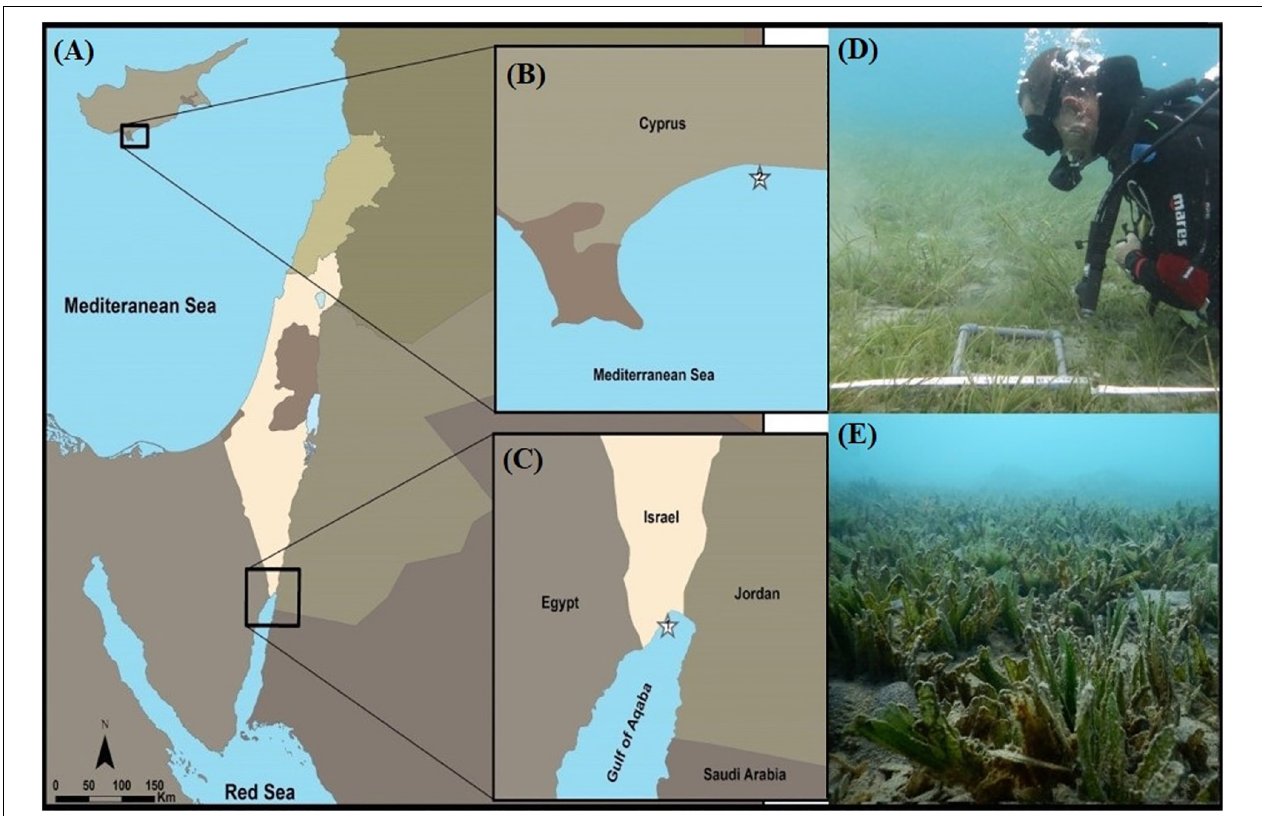
FIGURE 1 | Sampling sites of Halophila stipulacea (A–C) : (1) The native population, North Beach site, Eilat, northern Gulf of Aqaba (GoA, northern Red Sea, Israel). (2) The invasive population, growing at the Dream Café site, Limassol (eastern Mediterranean Sea, Cyprus). (D) Invasive H. stipulacea plants growing intermixed with plants of the native Mediterranean seagrass Cymodocea nodos a at the Dream café site (Photo: Yuval Sapir). (E) H. stipulacea growing in its native habitat in the GoA (Photo: Hung Manh Nguyen). Depths of both plant collection sites 3–4